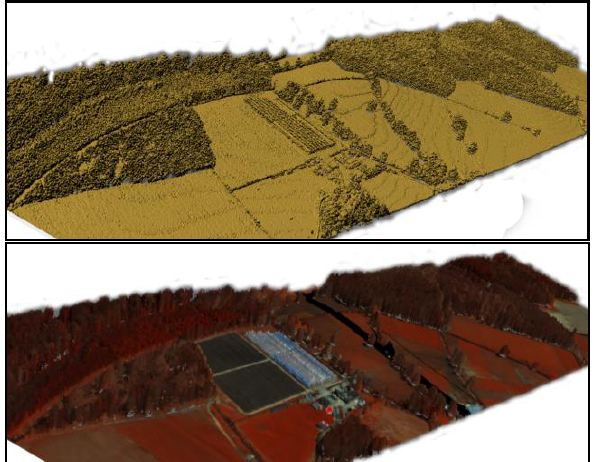
Figure 4. Visualisation results before and after projecting hyperspectral images on the polygon representation